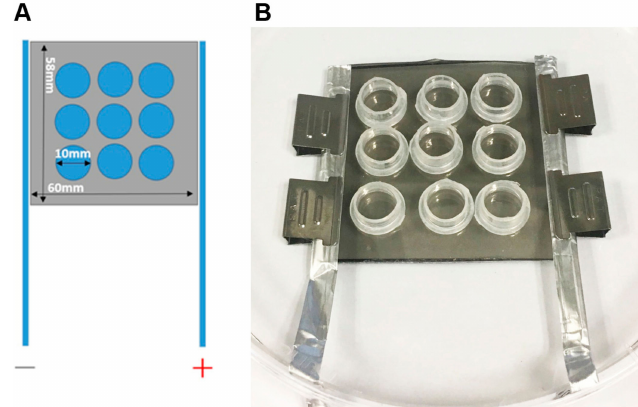
Figure 1. The layout of the electrical stimulation (ES) device and the actual fabrication format. ( A ) The design of substrate-mediated ES device. The polypyrrole (PPy) films were deposited on the tissue culture polystyrene (TCPS) dishes and trimmed to rectangles with dimensions of 60 mm × 58 mm. Nine polypropylene rings with diameters of 10 mm were glued onto PPy films to constrain the area of cell culture. Two electrodes were placed at the opposite ends of the PPy films and were connected in parallel to an external DC power source. ( B ) The actual photo of the ES